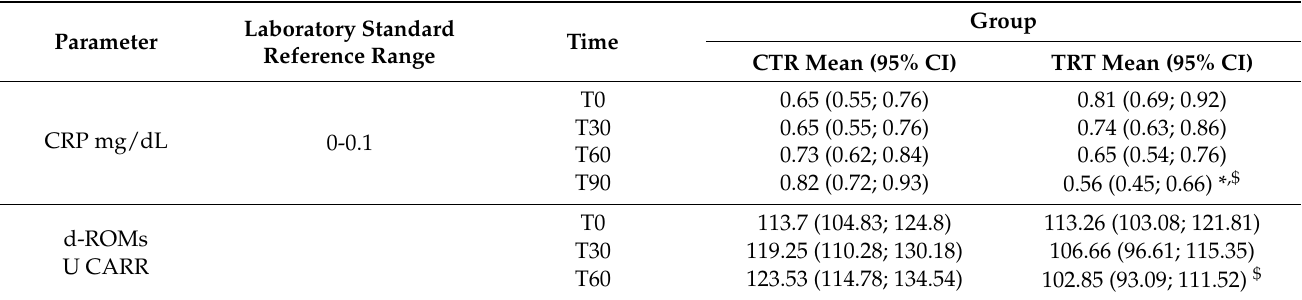
Table 7. C-reactive protein (CRP) and reactive oxygen metabolite-derived compound (d-ROMs).